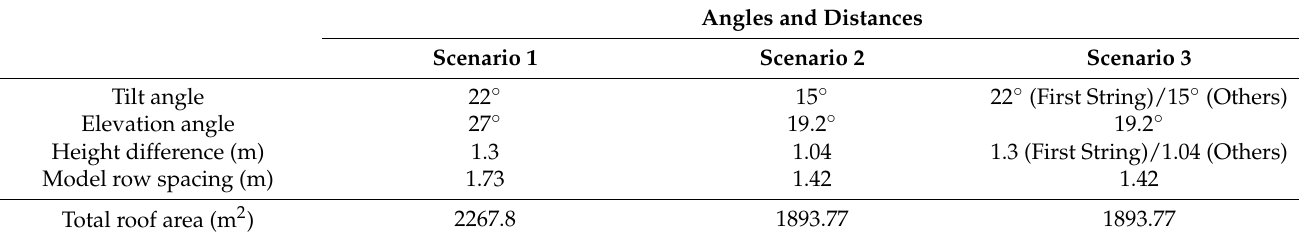
Table 2. Selected angles, distances, and the total roof areas for all